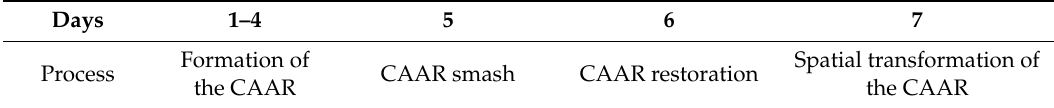
Table 7. Experimental